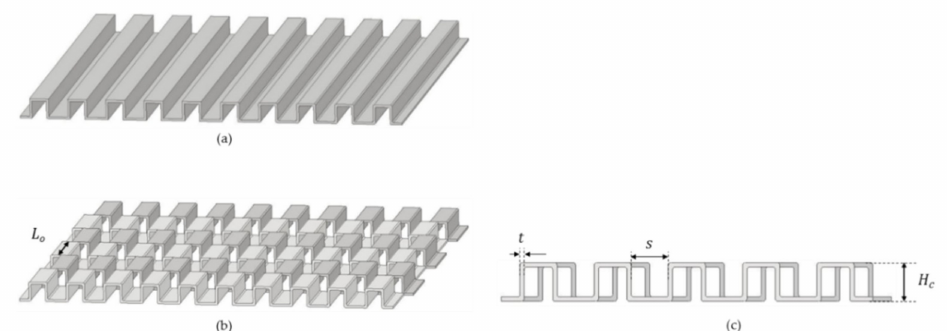
Figure 3. Drawing of rectangular plain and o ff set strip fins in the air-to-air plate heat exchanger for cold airflow, ( a ) rectangular plain fin shape; ( b ) o ff set fin shape; ( c ) geometry of o ff set fin ( L o , single o ff set fin length of cold air channel; t , fin thickness; s , length of fin pitch; H c , height of cold air channel).